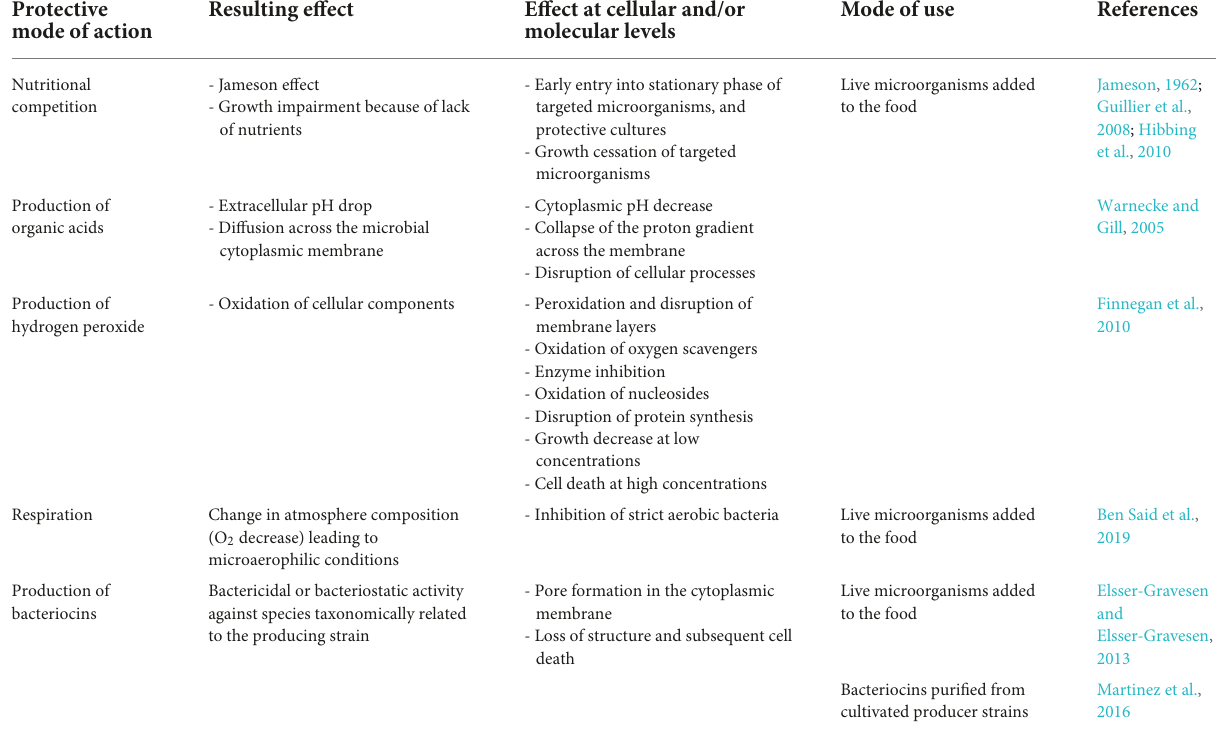
TABLE 1 Main characteristics of biopreservation in food and mechanisms